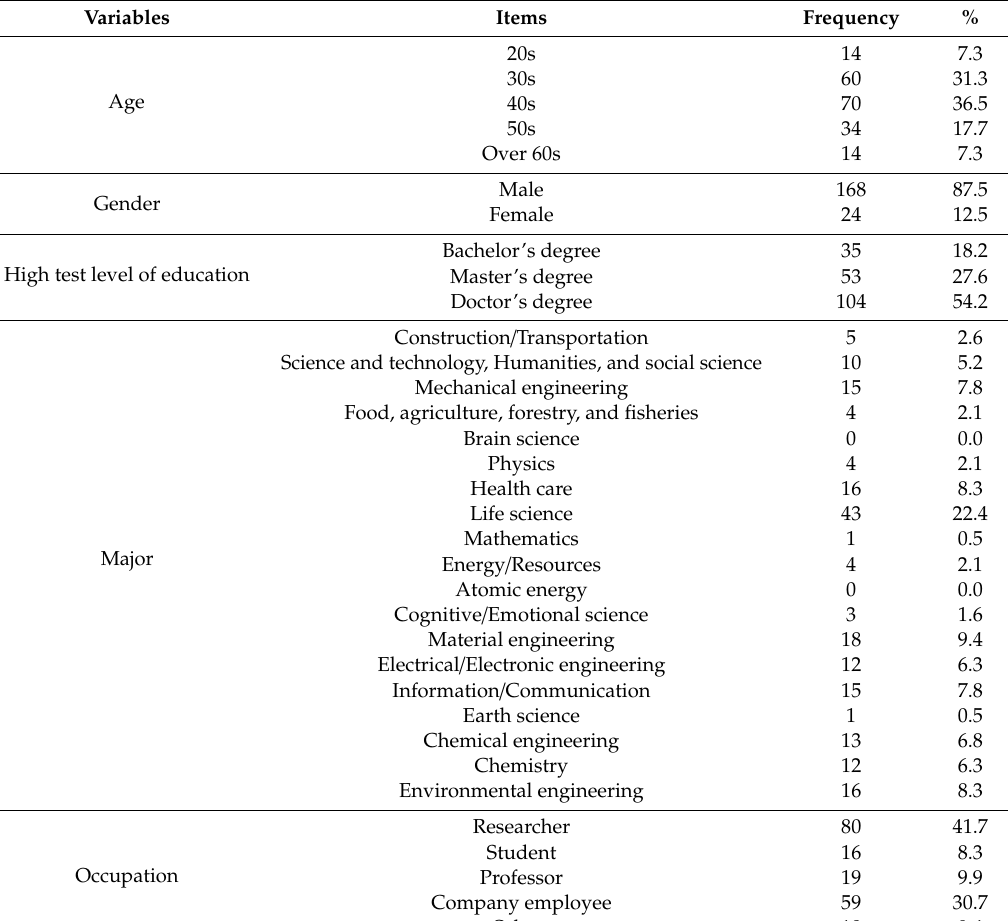
Table 4. Demographic